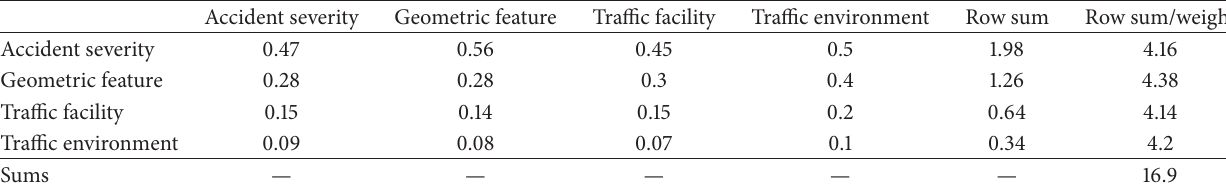
Table 2: Result of calculating constancy index of